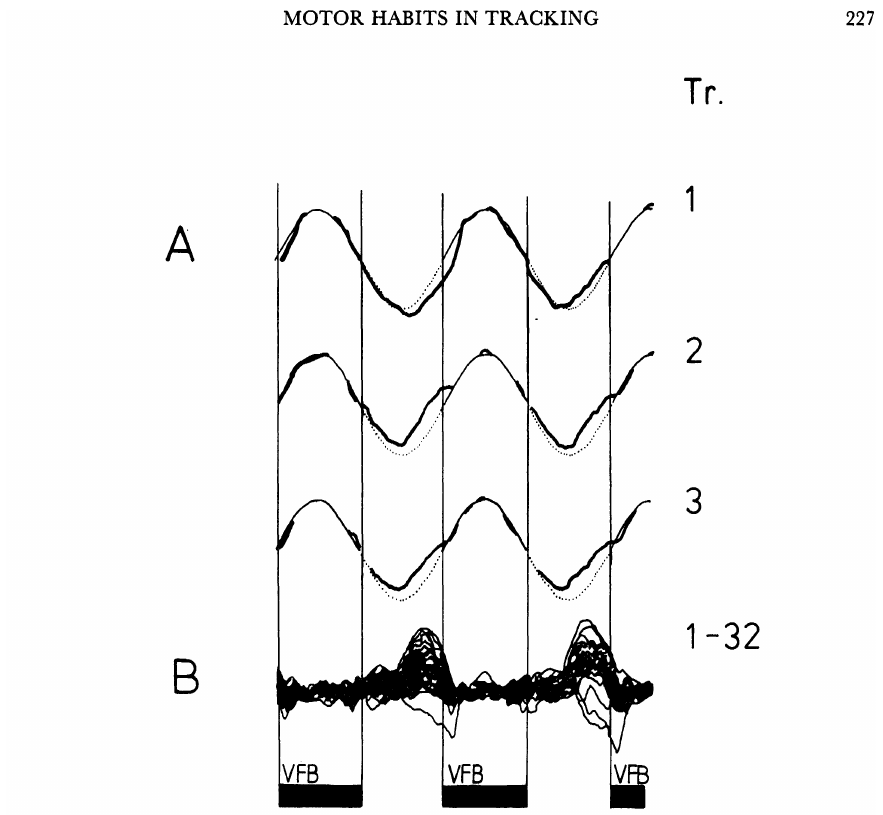
FIG. 5. (a) Single trials of a slow sinusoidal pursuit paradigm (experiment 2). Target movement: thin and dotted lines, pursuit: thick lines. Target movements to the right could be tracked by visual feedback (VFB). Target movements to the left were occluded from the subject's vision (dotted segments), leaving them to perform an arbitrary sinusoidal movement. (b) Superposition of error curves (tracking minus target curves) of 32 trials, indicating superior performance under visual